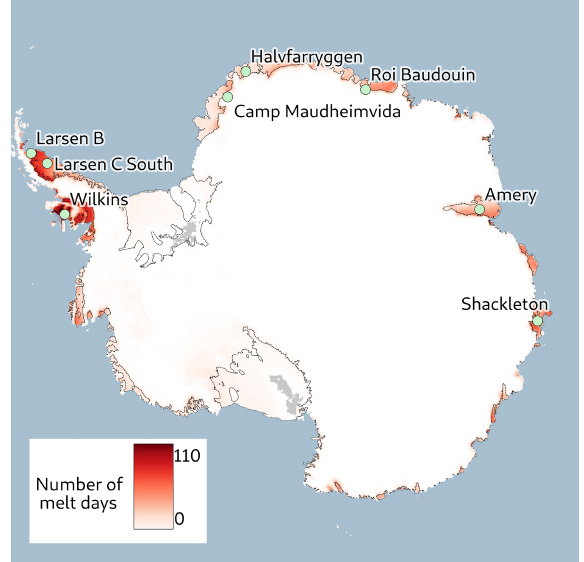
Figure 1. Map of Antarctica with the eight study sites. The annual mean number of melt days detected by the algorithm (Torinesi et al., 2003a) using AMSR2 19GHz with horizontal polarization and as- cending pass observations (2012–2022) is shown in red